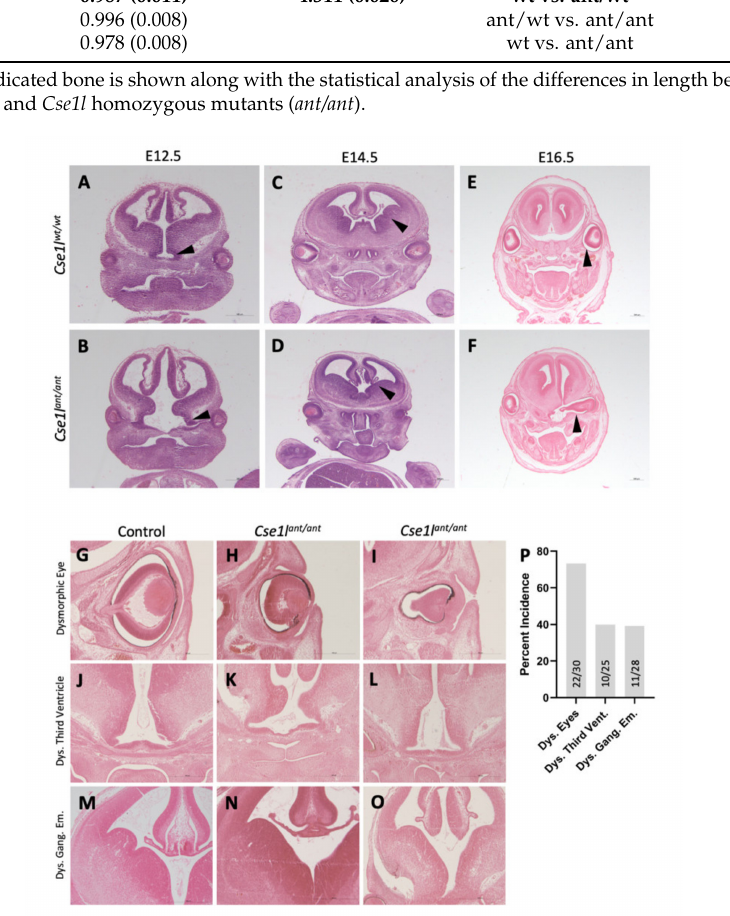
Figure 6. Histology of Cse1l ant/ant mutants reveals eye and brain structural abnormalities. Cse1l wt/wt at E12.5 ( A ), E14/5 ( C ) and E16.5 ( E ) and Cse1l ant/ant mutants at E12.5 ( B ), E14.5 ( D ), and E16.5 ( F ) show a range of phenotypes quantified in ( G ). ( H – P ) Detailed view of ocular ( I , J ), third ventricle ( L , M ) and ganglionic eminence ( O , P ) Cse1l ant/ant mutant